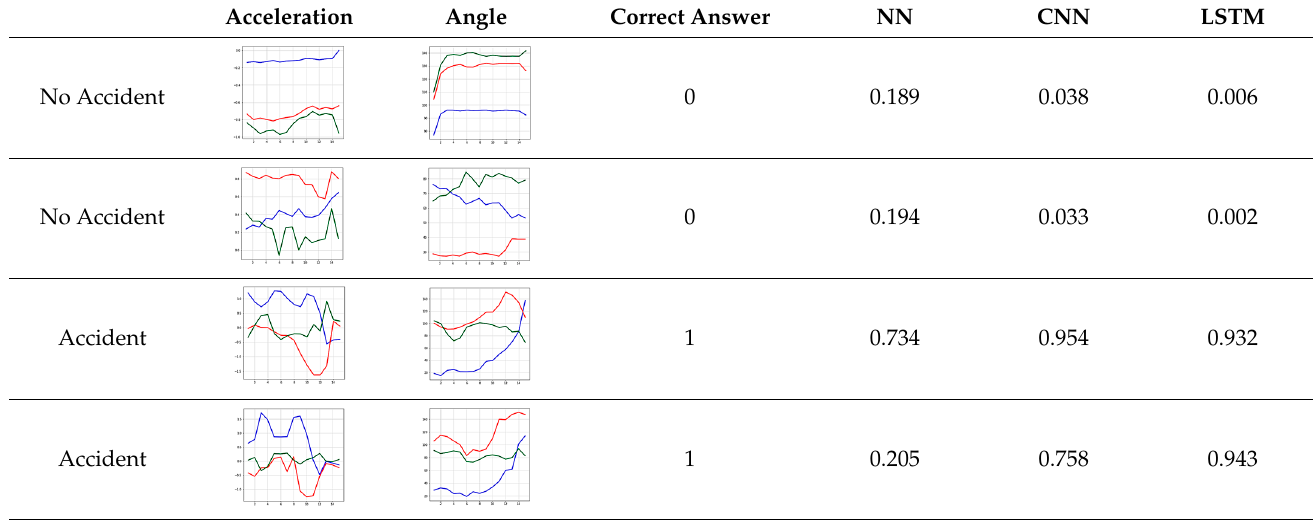
Figure 11. Training accuracy and loss. The horizontal axis of the graphs indicates the number of learning cycles. Table 2. Comparison of a NN, CNN, and LSTM.